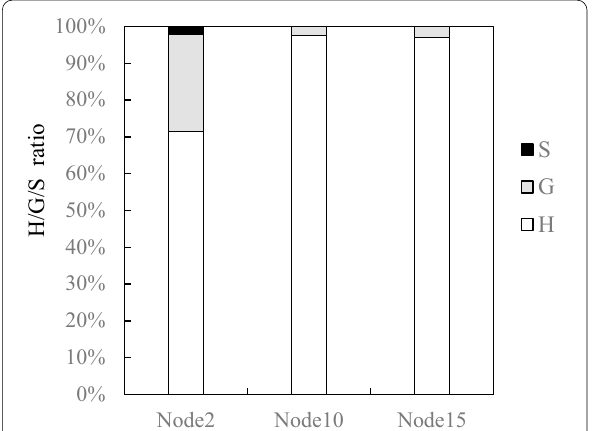
Fig. 6 H/G/S ratio of lignin in the early‑growth stage. H/G/S ratios of pyrolysis products of lignin in the early‑growth stage. The samples were nodes 2, 10, and 15